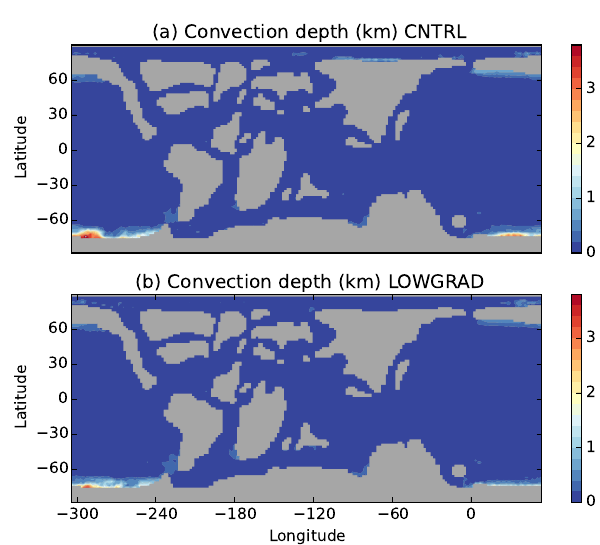
Figure 2. Maximum convection depth in km in (a) CNTRL and (b)